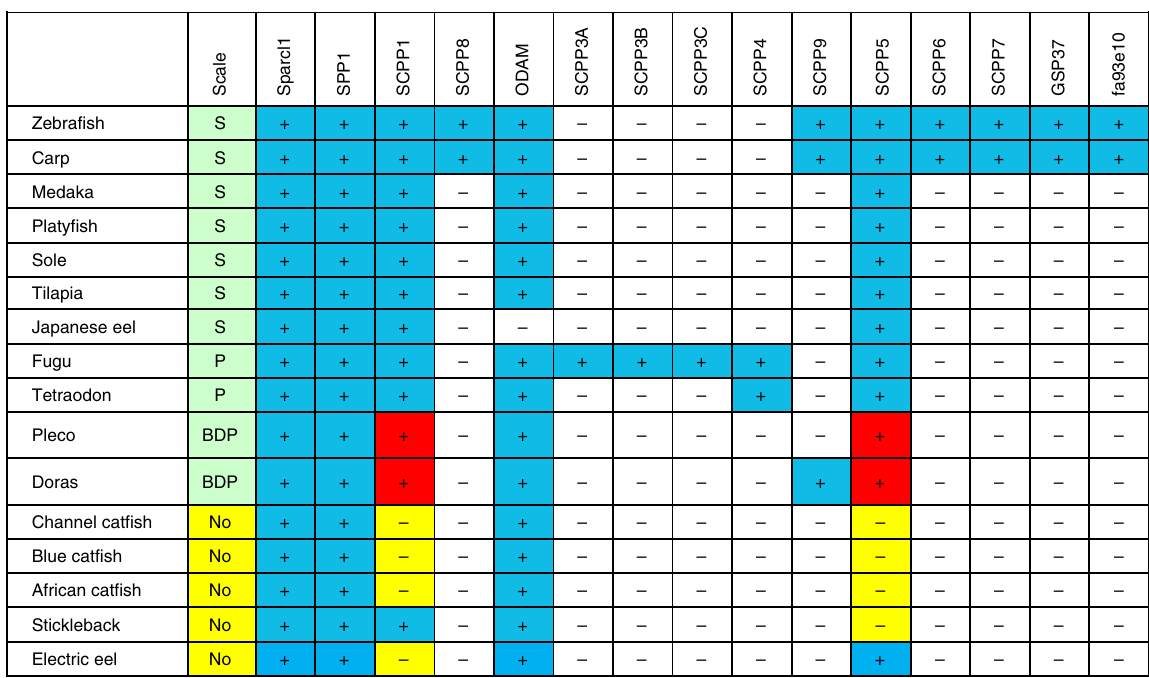
Figure 6 | Status of SCPP genes in channel catfish and various other fishes. ( a ) Conserved syntenic regions of catfish and zebrafish containing SCPP genes were identified. In zebrafish, the SCPP genes were located on chromosomes 1, 10 and 5, whereas in channel catfish the SCPP genes were on chromosomes 4, 29 and 16. Note that SCPP7, SCPP6, SCPP9, SCPP8 and GSP37 are missing from the channel catfish genome (underlined). ( b ) Comparison of SCPP1 genes in channel catfish, pleco, zebrafish and fugu, noting that three exons (2, 5 and 6; light shaded) the channel catfish SCPP1 gene was mutated or deleted. ( c ) Comparison of SCPP5 genes in channel catfish, pleco, zebrafish and fugu, noting that only a small segment (green box) of SCPP5 homologous sequences was present as remnant, and most of its coding sequences are deleted. ( d ) Alignment of the sequences in the promoter regions of SCPP5 in fugu, tilapia and medaka, noting the highly conserved sequences in the transcriptional factor binding sites, which are entirely lost in the channel catfish gene (not shown). ( e ) Alignment of the sequences in the promoter regions of SCPP1 in fugu, tilapia, medaka, zebrafish and pleco, noting the highly conserved ETS2 transcriptional factor binding sites, which are lost in the channel catfish gene (not shown). ( f ) Status of SCPP genes in various teleost species in relation to their scale status (BDP, bony dermal plates; No, no scales; S, scaled; P, protuberance). Pluses ( þ ) in blue shading indicate presence of SCPP genes, and minuses ( (cid:2) ) indicate absence of the SCPP genes; yellow shading highlights specific absence of the SCPP genes in scaleless fishes, and red shading indicates presence of SCPP1 and SCPP5 in scaled catfish common pleco (pleco) and southern striped Raphael